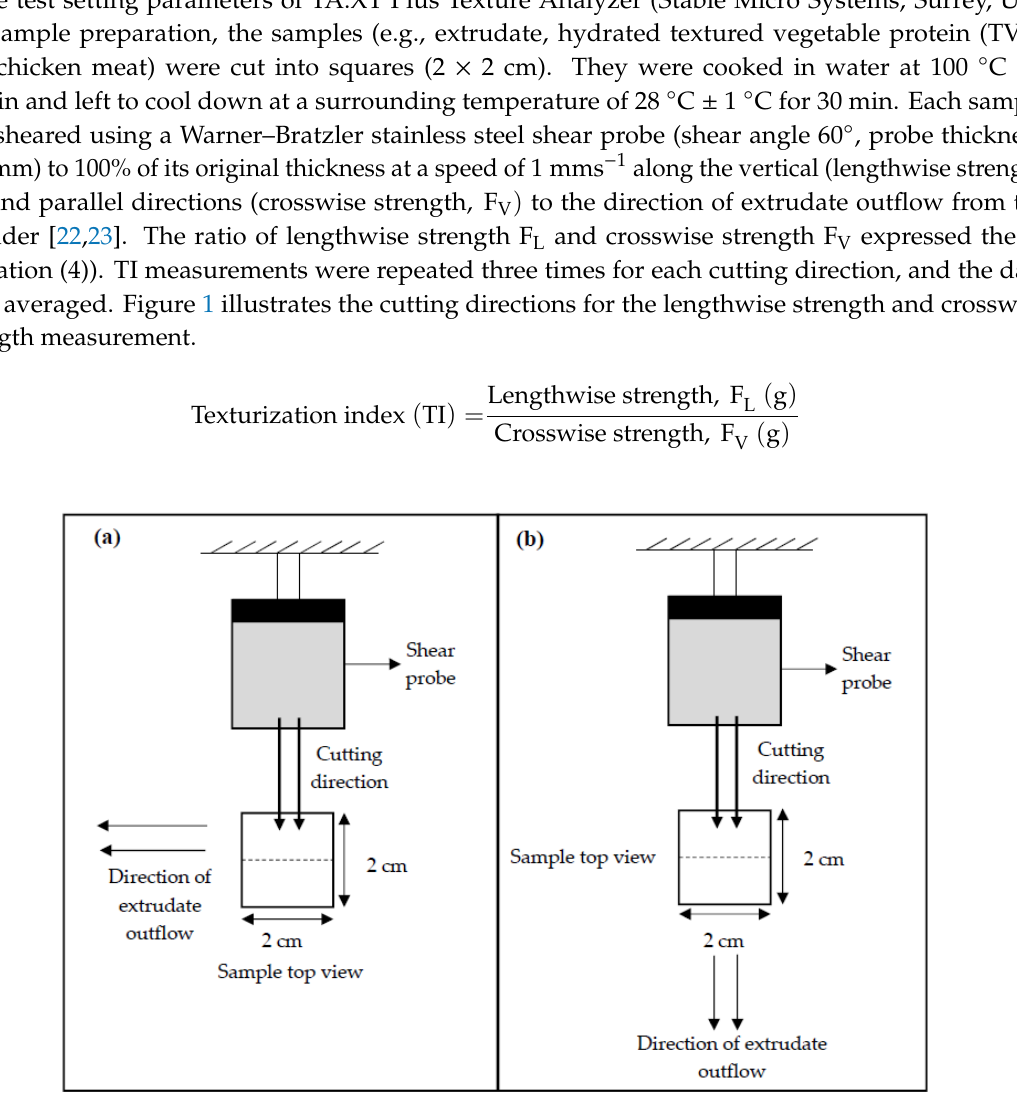
Figure 1. Test setup for the determination of ( a ) crosswise strength F V and ( b ) lengthwise strength F L